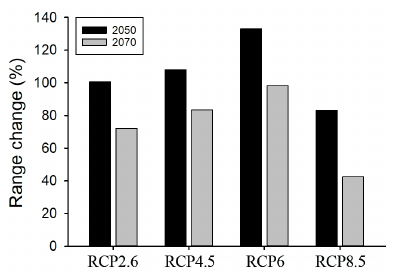
Figure 5. Range size change in Paradoxornis heudei in 2050 and 2070 under four RCPs.